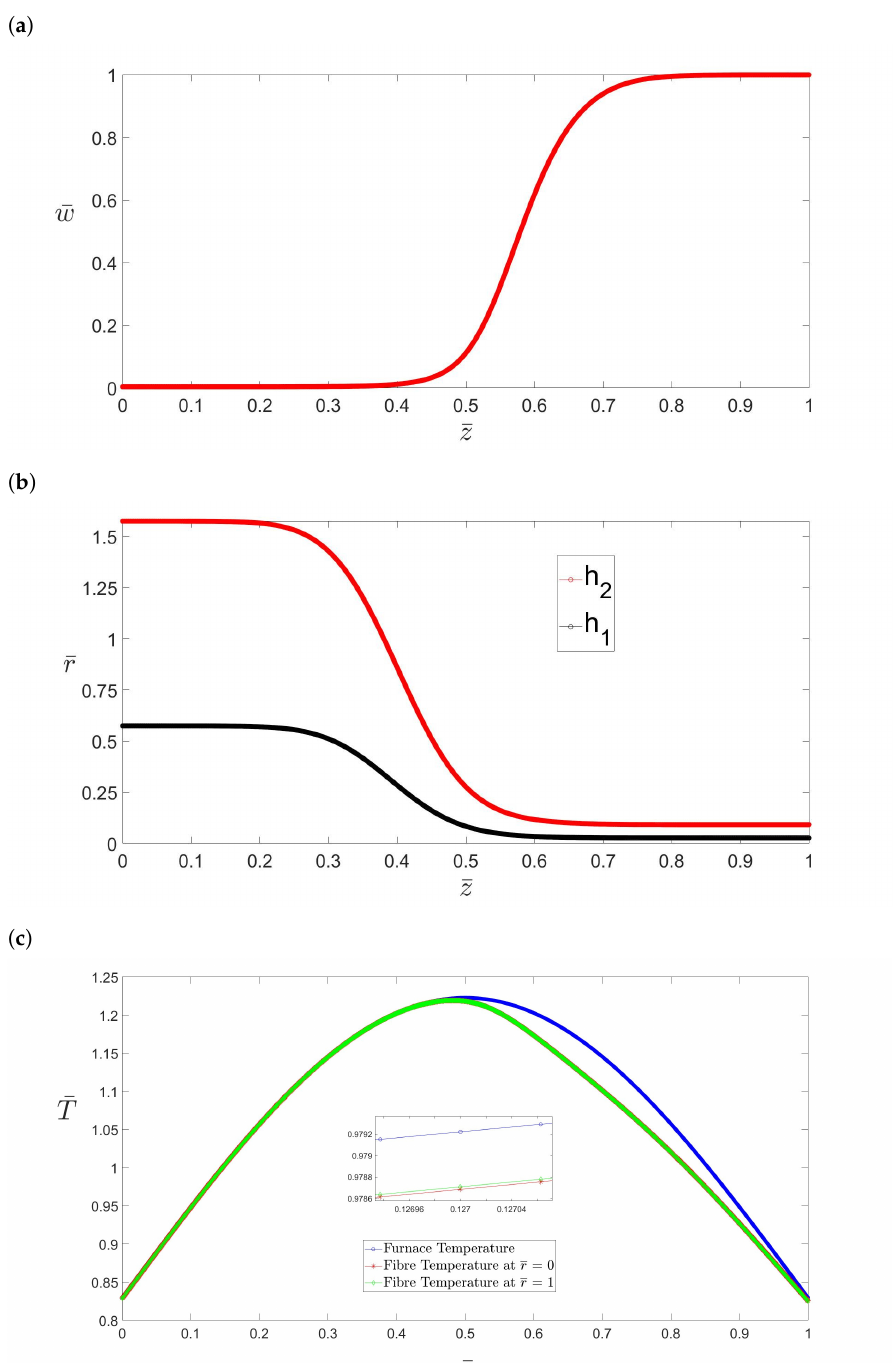
Figure 3. ( a ) Evolution of the axial component of the velocity w against the axial distance z . The inner and outer surfaces of the capillary, h 1 and h 2 , respectively, are plotted against the axial distance z in ( b ). The temperature profiles of the inner and outer capillary surfaces are plotted against the axial distance z together with the temperature profile of the furnace in ( c ). The inset in ( c ) magnifies the difference among the plotted temperature profiles of capillary surfaces and the temperature profile of the